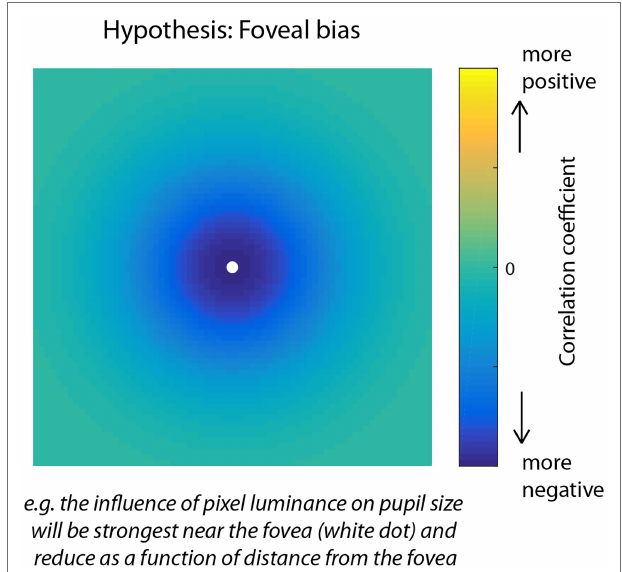
FIGURE 2 | Visual representation of the foveal bias hypothesis for the correlation map analysis of Experiment 1. Due to the density of photoreceptors and sensitivity of the pupillary light response (PLR) to foveal vs. peripheral light stimulation, we predicted that pixels nearest fixation would correlate the most negatively with pupil size over time, and pixels further away would correlate less. The predicted negative correlation is due to the inverse relationship between light intensity and pupil size in which increases in luminance induce constrictions of the